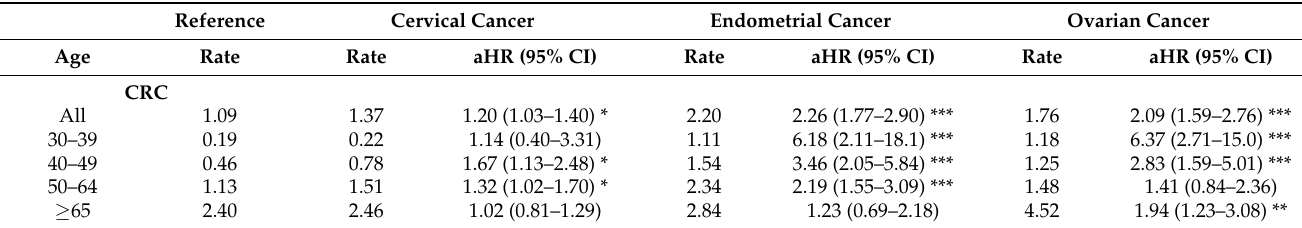
Table 2. Incidence of colorectal cancer and gynecologic cancer cohorts to reference cohort adjusted hazard ratio by age.